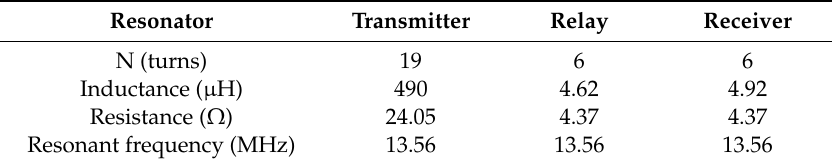
Table 1. Simulated electrical parameters of